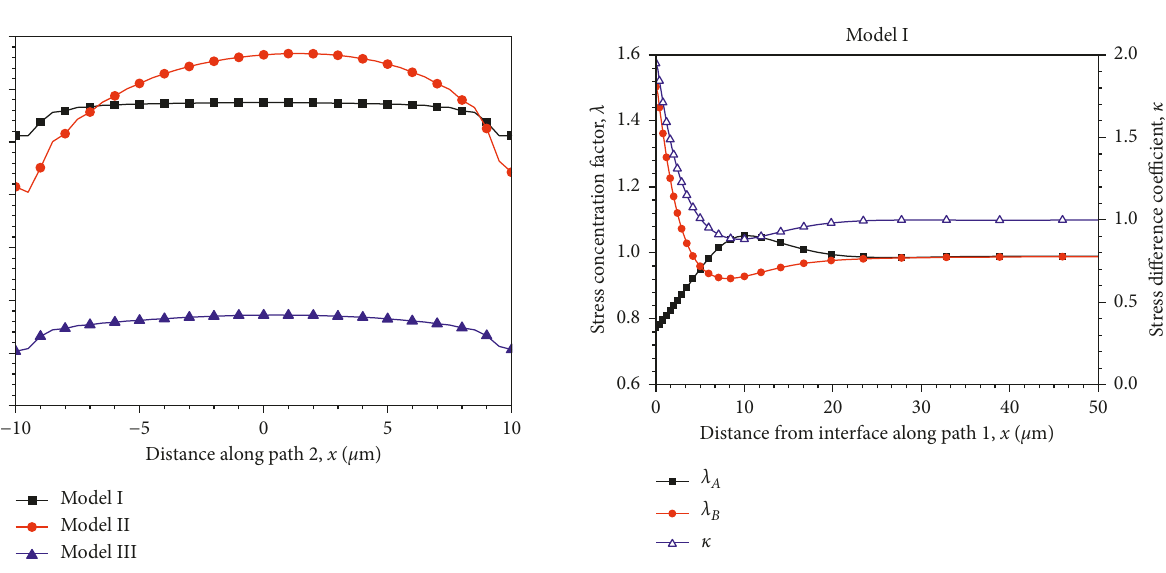
Figure 8: Mises stress difference coefficient on the GB along path 1.